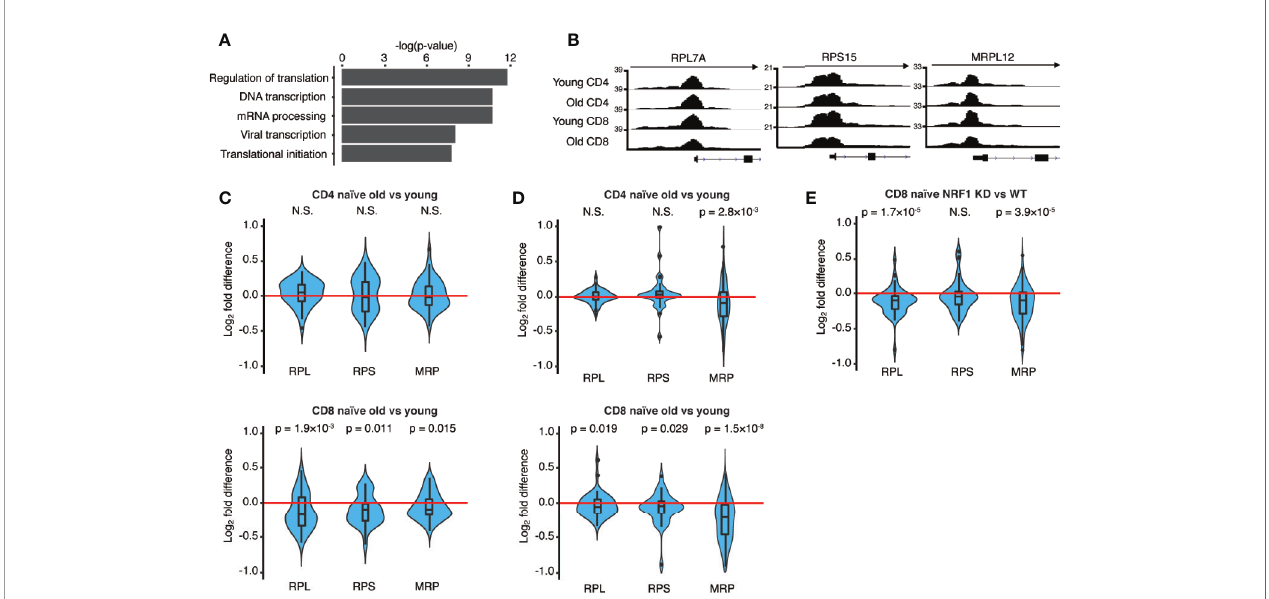
FIGURE 6 | Age-associated effects on ribosome proteins in CD8 T cells at the epigenetic and transcriptional level. (A) The top fi ve biological processes enriched in Cluster 3 ( Figure 5A ) as determined by DAVID Functional Annotation Tool. Genes were identi fi ed within 10 kb of a differentially accessible region using HOMER. Corresponding analyses for the other clusters are shown in Supplemental Figure 10 . (B) ATAC-seq signal tracks showing chromatin accessibility of representative ribosome protein genes. (C) Violin plots showing the fold difference of accessibilities for ribosome protein (large subunit, RPL; small subunit, RPS; and mitochondrial, MRP) comparing naïve CD4 (upper panel) and CD8 T cells (lower panel) from young and old adults, positive values mean more open in the old. Statistical analysis by Wilcoxon rank sum tests. (D) Violin plots showing the fold difference of ribosome protein (RPLs, RPSs and MRPs) transcripts comparing naïve CD4 (upper panel) and CD8 T cells (lower panel) from young and old adults, positive values mean more expressed in the old. Transcript data are from RNA-seq of CD4 and CD8 T cells from 5 young and 6 old adults. Statistical analysis by Wilcoxon rank sum tests. (E) Violin plots showing the fold differences of ribosome protein (RPLs, RPSs and MRPs) comparing NRF1 knockdown cells to control transfected cells, positive values mean more expressed in NRF1 knockout cells. Transcript data are from naïve CD8 T cells from three young adults transfected with either NRF1 siRNA or control siRNA (dbGaP accession #: phs001187.v1.p1). Statistical analysis by Wilcoxon rank sum